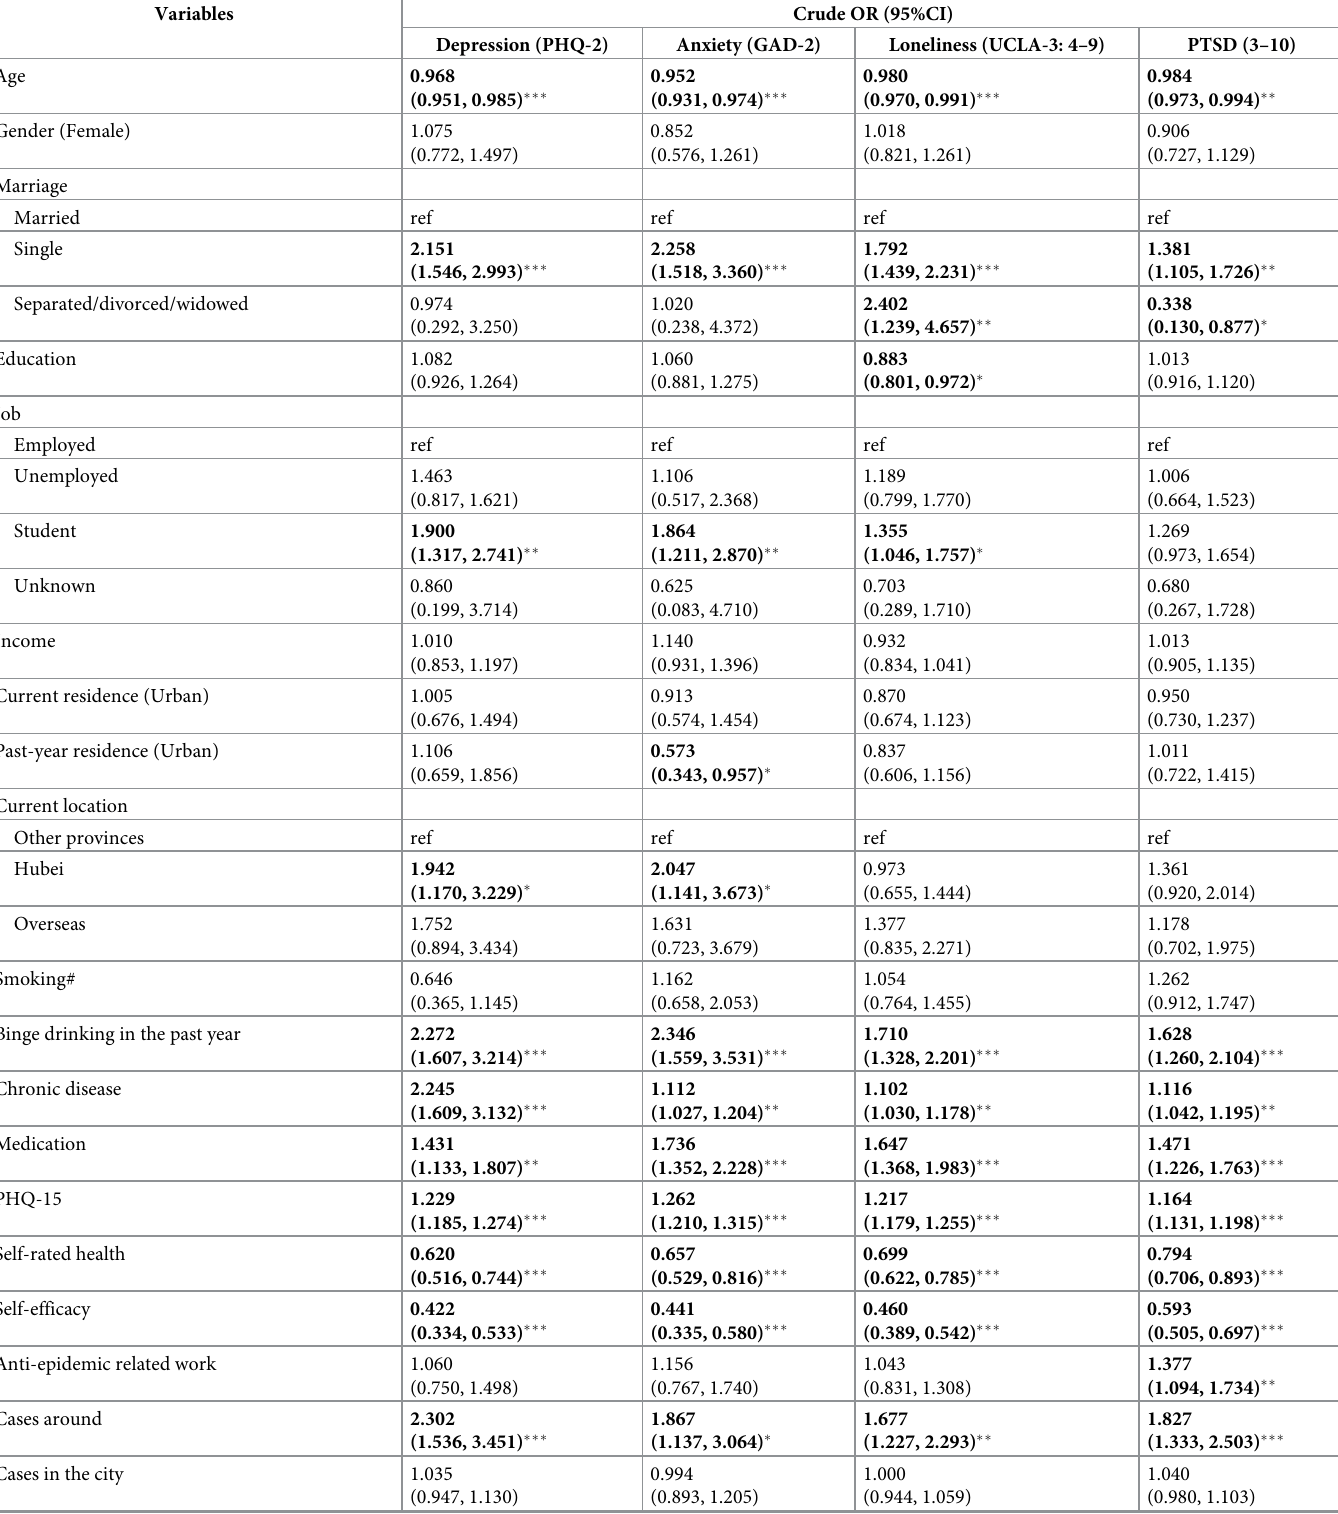
Table 2. Univariable logistic regression analysis of factors influencing mental health